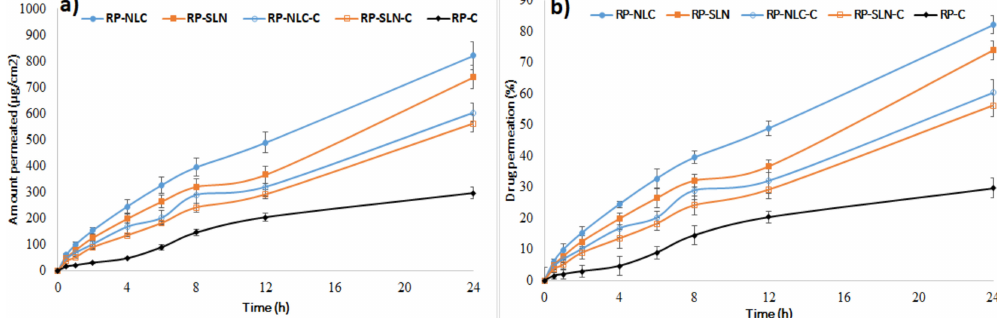
Figure 2. Amount of drug permeate ( a ) and percentage drug permeation ( b ) of RP from RP loaded lipid nanoparticles, hydrogel formulations and control formulations through rat skin (mean ± SD, n =